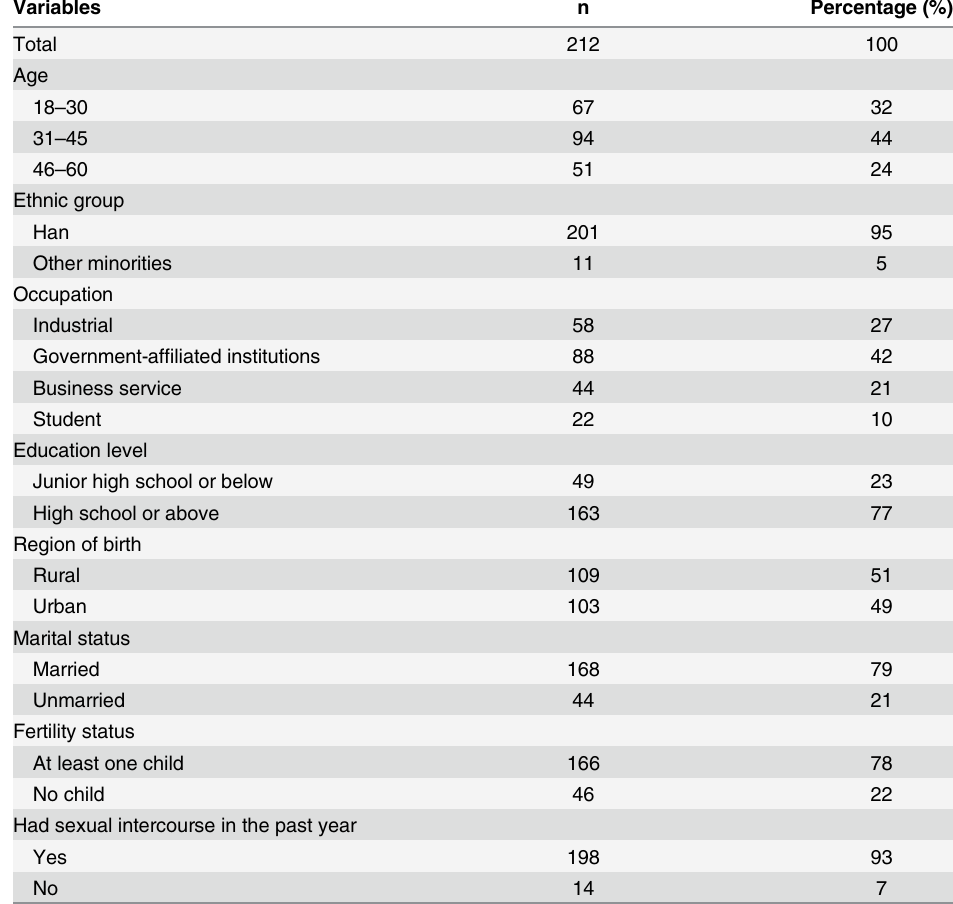
Table 1. Demographic characteristics of the study